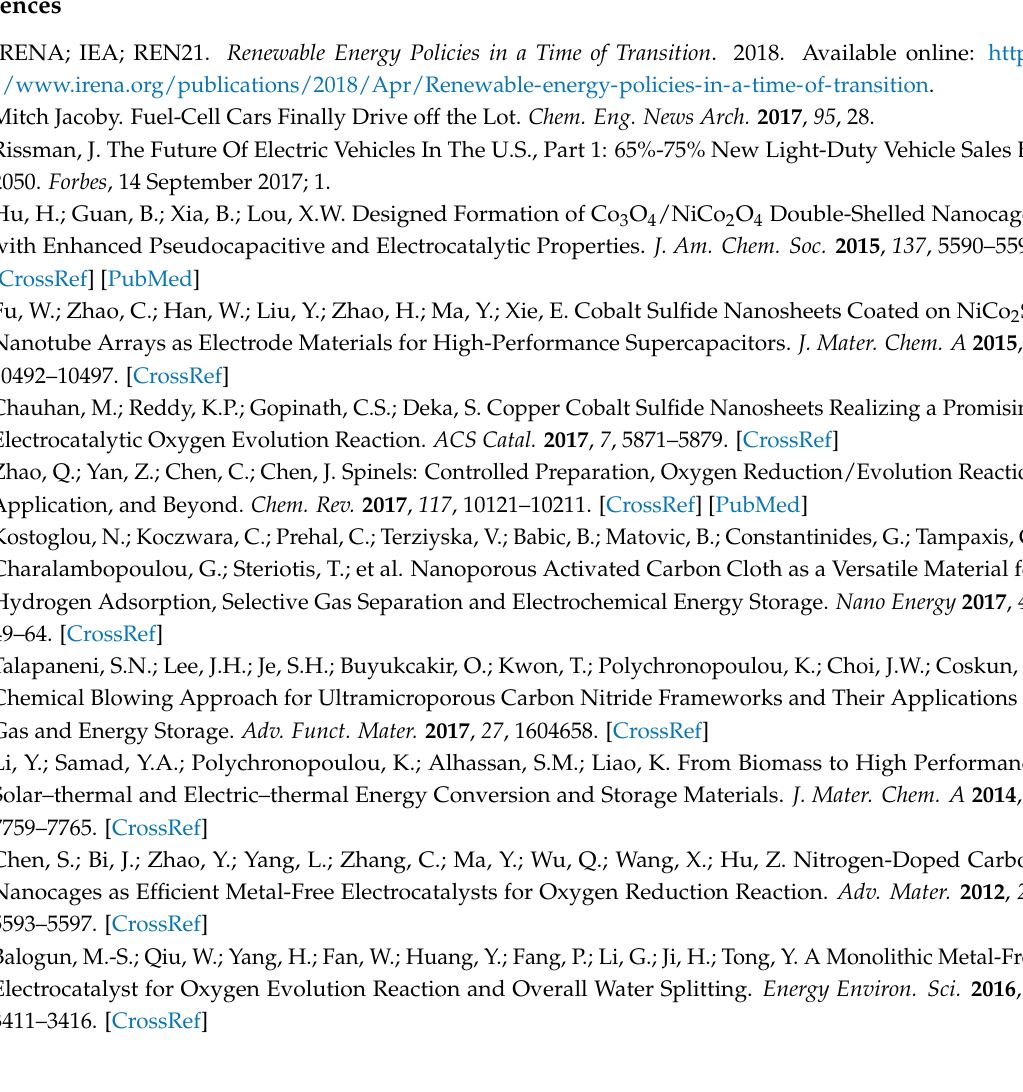
Figure S1. XRD patterns of (a) CoFe 2 O 4 , (b) CoFe 2 O 4 ED@CCC and CoFe 2 O 4 ED@NF. Figure S2. XPS wide scan of the CoFe 2 O 4 . Figure S3. SEM images of electrodeposited CoFe 2 O 4 on carbonized carbon cloth. Figure S4. Nyquist plots for the CoFe 2 O 4 ED@NF sample at various potentials (vs. SCE). Figure S5. CV curves in non-faradic region for (a) CoFe 2 O 4 ED@NF, (b) CoFe 2 O 4 @NF, and (c) CoFe 2 O 4 ED@CCC. Figure S6. (a): Polarization curves, (b) Tafel slopes, and (c) chronoamperometry data for CoFe 2 O 4 ED@NF in HER range. Figure S7. (a) CV curves and (b) GCD curves of CoFe 2 O 4 ED@NF obtained at various scan rates and current densities in 3M KOH electrolyte. Figure S8. Cyclic stability plot for CoFe 2 O 4 ED@NF sample using 10,000 galvanostatic charge-discharge measurements. Table S1. Comparison of OER performance of some recently reported FeCo-based electrocatalysts. Table S2. Comparison of HER performance of some recently reported electrocatalysts in alkaline media. Table S3. Comparison of specific capacitances of some reported FeCo-based